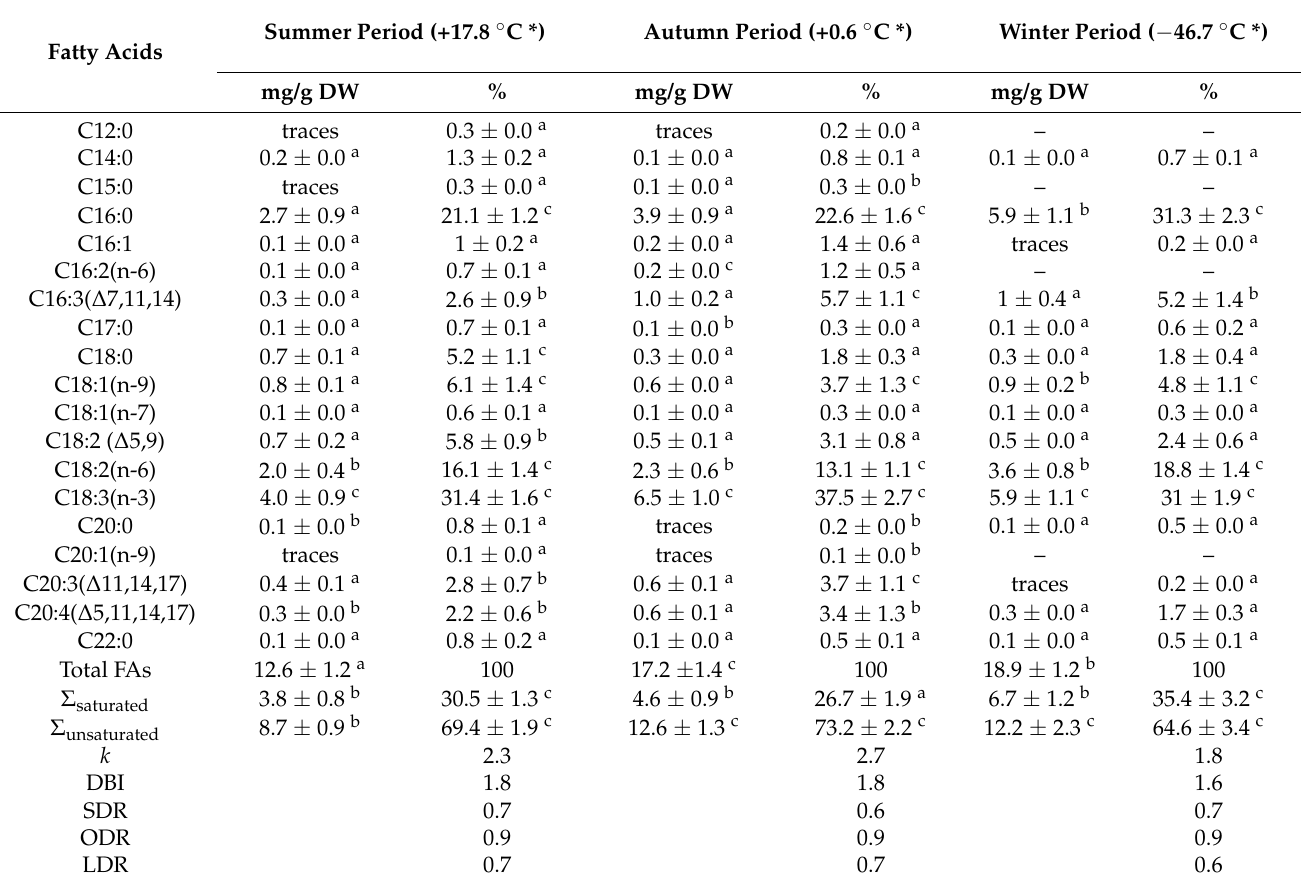
Table 2. Seasonal changes in the FA composition of lipids in shoots of Equisetum scirpoides growing at the Pole of